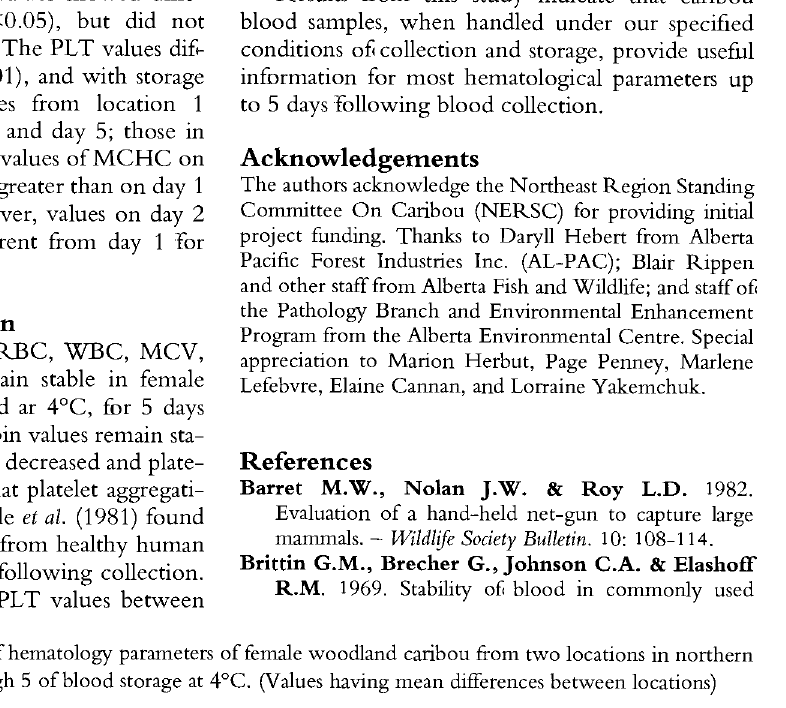
Table 2. Mean ± standard error of hematology parameters of female woodland caribou from two locations in northern Alberta, on days 1 through 5 of blood storage at 4°C. (Values having mean differences between